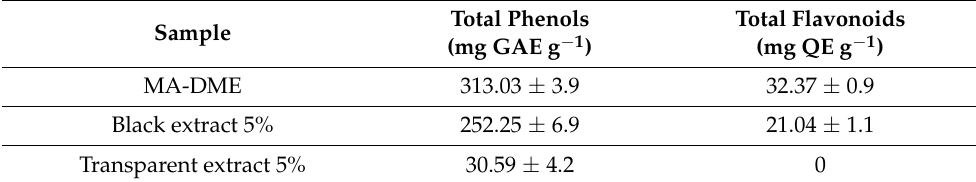
Table 2. Total phenolic content and flavonoid content in